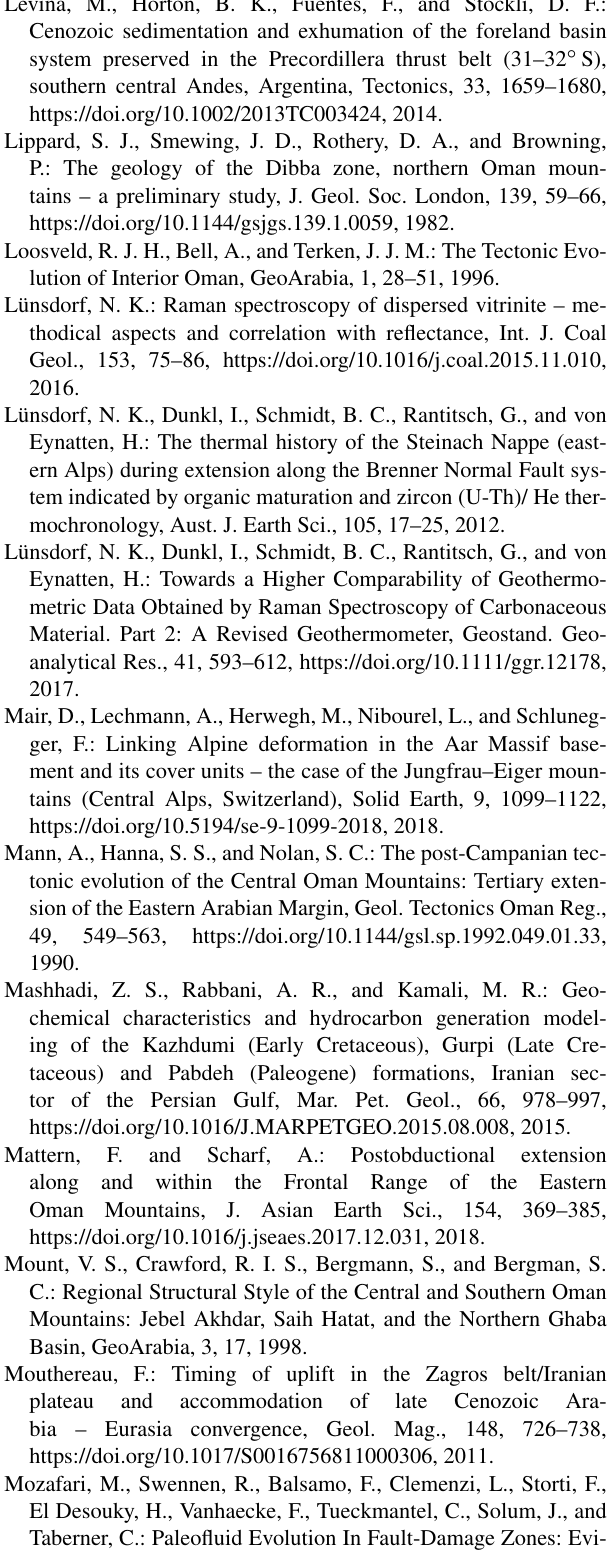
Taberner, C.: Paleofluid Evolution In Fault-Damage Zones: